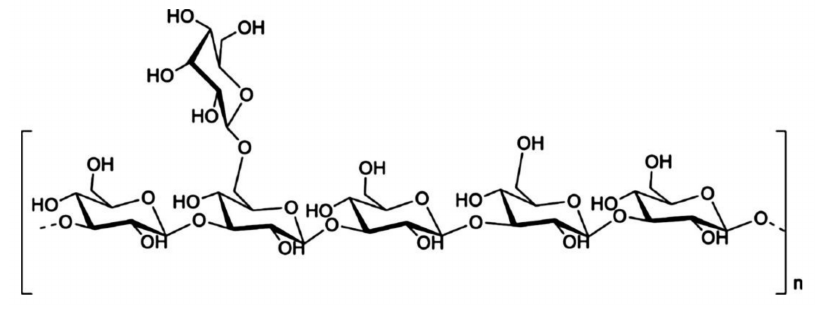
Figure 9. A schematic diagram of β -glucan structure in Poria cocos